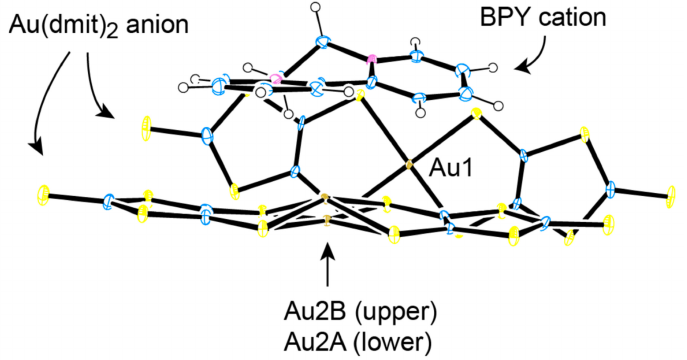
Figure 9. Crystal structure of BPY[Au(dmit) 2 ] 2 [13]. The orange, blue, violet, and green spheres designate sulfur, carbon, nitrogen, and gold atoms, respectively. Hydrogen atoms are designated by black open circles.